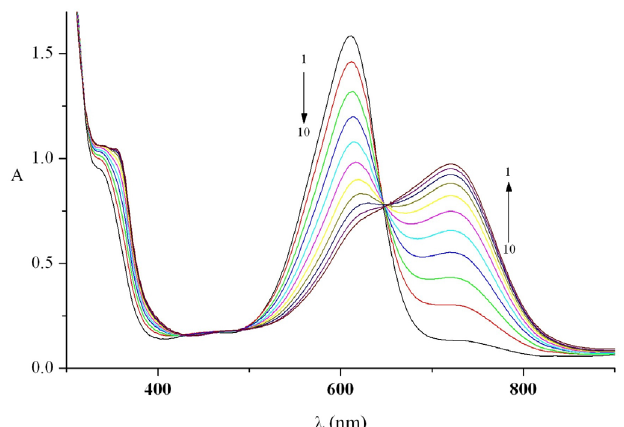
FIGURE 6 - UV-Vis spectra obtained for 1.0x10 -4 mol L -1 indigo carmine in 0.1 mol L -1 carbonate buffer solution at pH 10 in the presence of Cu(II) solutions: 1)1.0; 2)2.0 3)3.0; 4)4.0; 5)5.0;